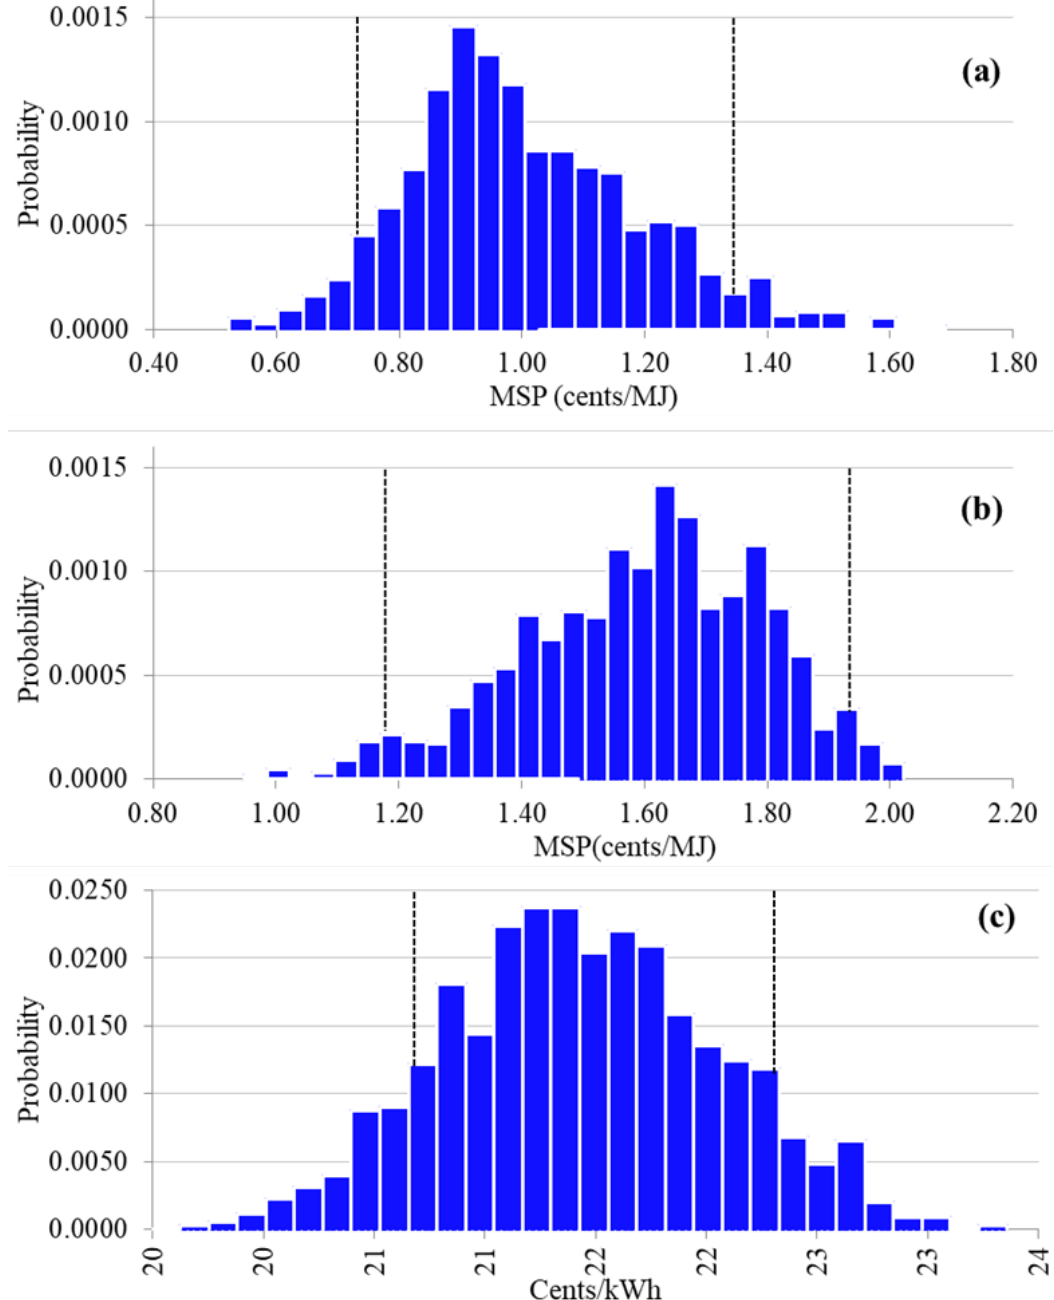
Figure 10. Probability distribution of the minimum selling price for heat from wood briquettes ( a ), and torrefied wood briquettes (TWBs) ( b ), and electricity production from TWBs ( c ) calculated with Monte Carlo